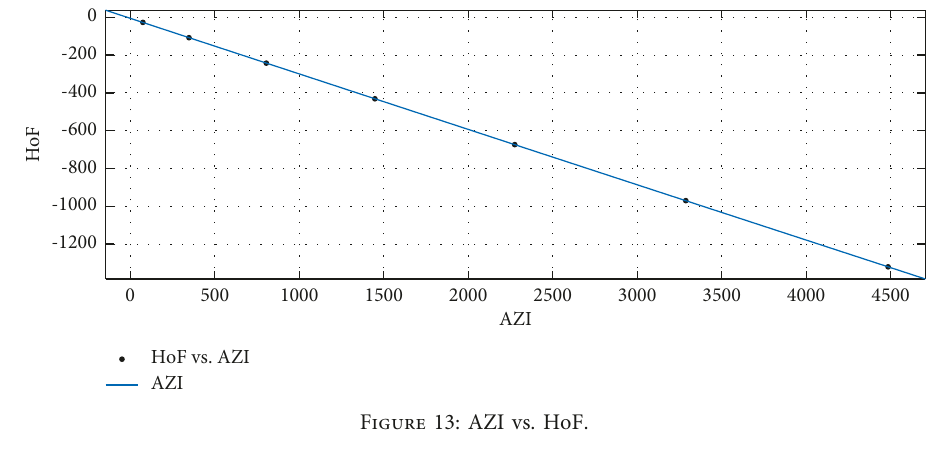
Figure 13: AZI vs. HoF.